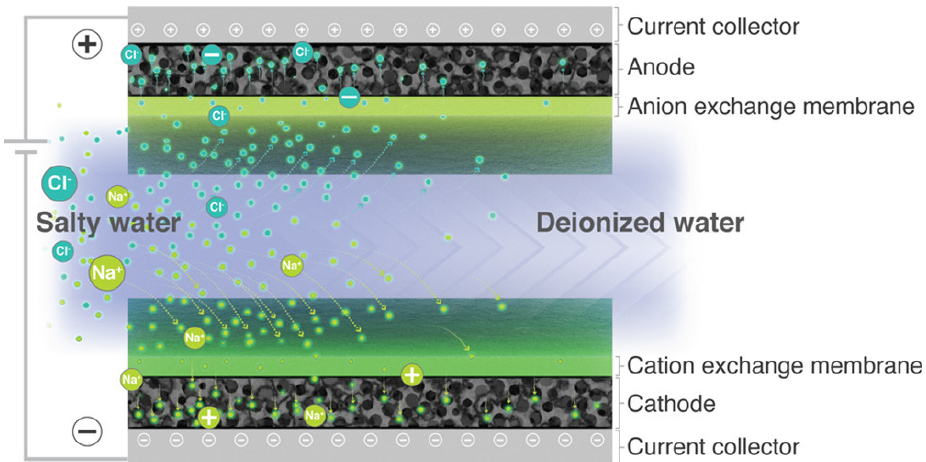
Figure 4. Schematic representation of the typical symmetric MCDI cell configuration: anode, posi- tively polarized electrode; cathode, and negatively polarized electrode. Reproduced with permission from [50], used under CC-BY 4.0.